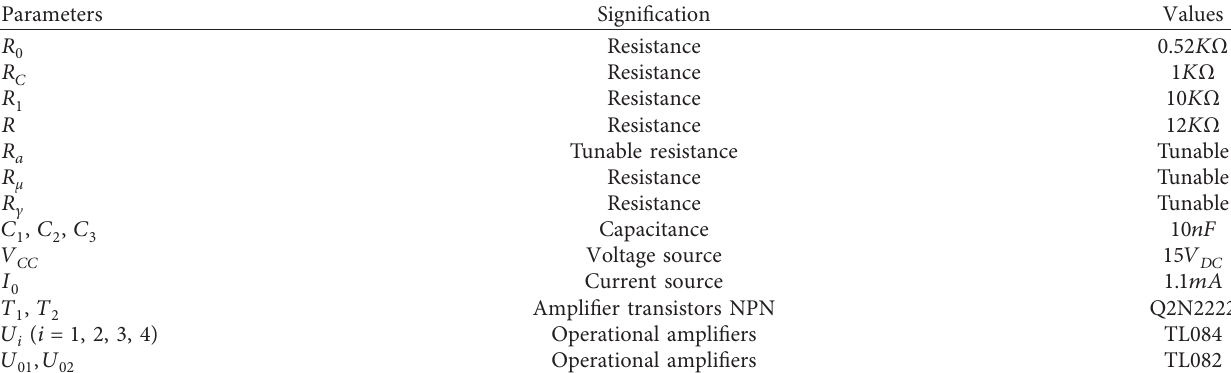
Table 2: The values of electronic components used for PSpice